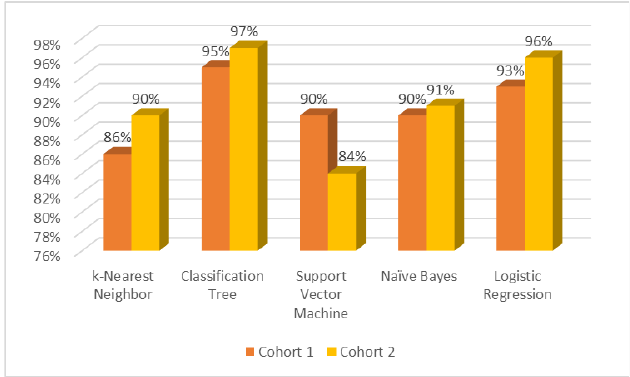
Fig. 5. Classifiers comparison with